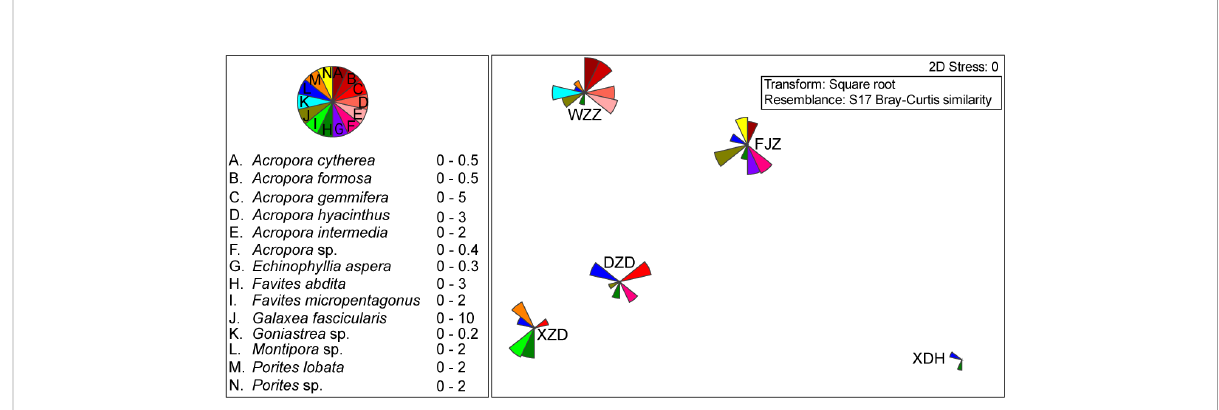
FIGURE 3 Non-parametric multi-dimensional scaling (nMDS) ordinations visualized the similarities and dissimilarities in coral community composition (living coral cover served as the abundance) between stations, with a bubble plot showing the live cover of the coral species preferred by Drupella spp. (Ei >0.5 at any station) in each sample station (XZD, Xiaozhoudao; XDH, Xiaodonghai; WZZ, Wuzhizhou; FJZ, Fenjiezhou; and DZD, Dazhoudao).